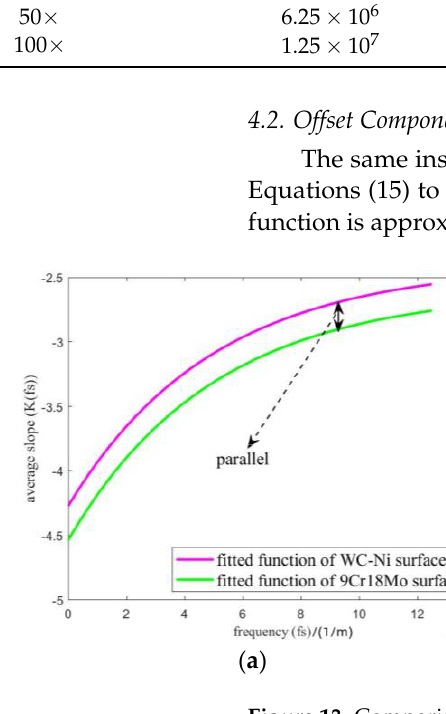
Figure 13. Comparison of the two experimental results. ( a ) slopes; ( b ) intercepts.